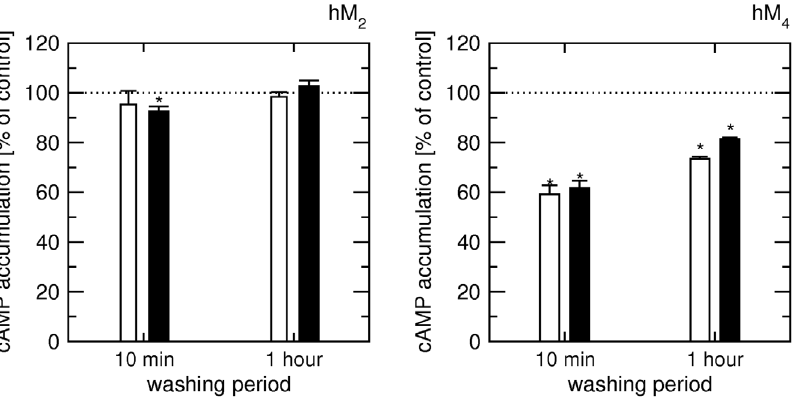
Figure 8. Effects of xanomeline on the accumulation of cyclic AMP. Cells expressing hM 2 (left) or hM 4 (right) receptors were treated with 10 m M xanomeline for 3 min followed by washing for 10 min or 1 hour (coordinate) prior to 20-min incubation with 5 m M (white bars) or 20 m M (black bars) forskolin. Accumulation of [ 3 H]cAMP (ordinate) is expressed as per cent of control accumulation of [ 3 H]cAMP in xanomeline sham treated cells (corrected for content of protein). Data are means 6 S.E.M. from 3 experiments performed in triplicates. * , different from control (sham treated) cells by t-test, P , 0.05.